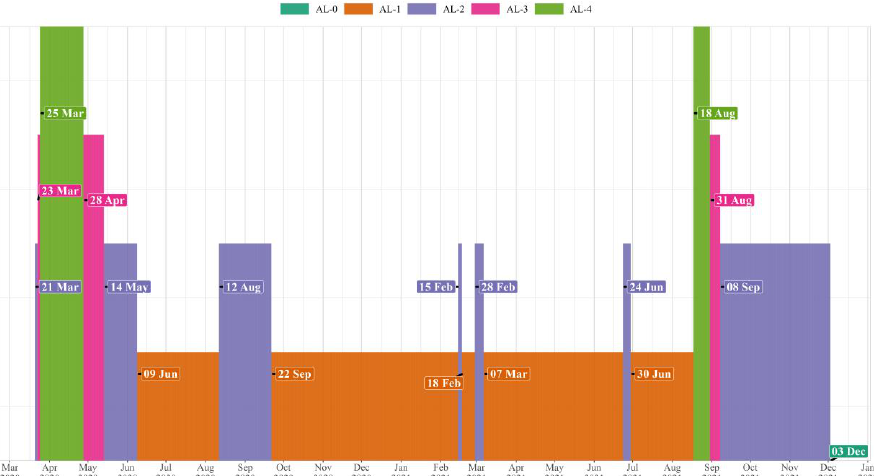
Figure 1. Wellington, New Zealand, COVID-19 Alert Level restrictions and dates from 2019 to 2021. Alert Level (AL) restrictions increase in strictness, with AL-4 being the strictest (everything except essential services closed). The start dates of the Alert Level periods are shown in the labels.